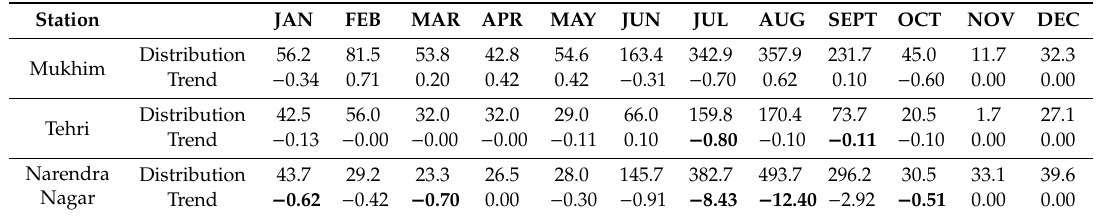
Table 5. Monthly rainfall distributions and trends in the Bhilangana river basin (mm / decade, 1983–2008) based on station observed data.